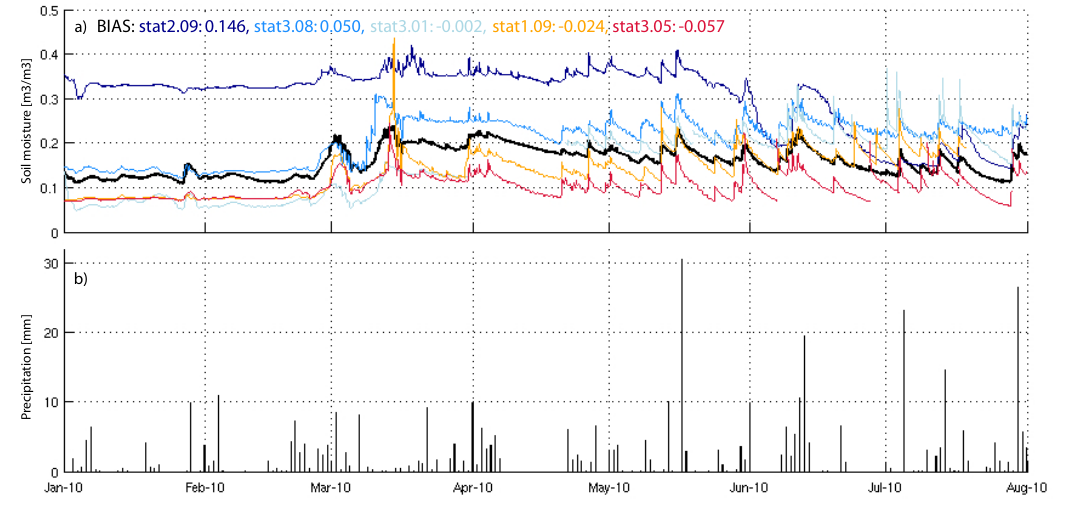
Fig. 9. (a) Surface soil moisture (0–5cm) with decreasing/increasing clay/sand fractions, respectively, between January and Au- gust 2010: agricultural stations 2.09 (dark blue), 3.08 (blue), 3.01 (light blue), 1.09 (orange) and 3.05 (red) compared to the average of all 30 network stations (black) including corresponding biases; and (b) mean of daily precipitation of the DMI 10km grid nodes contained within the SMOS